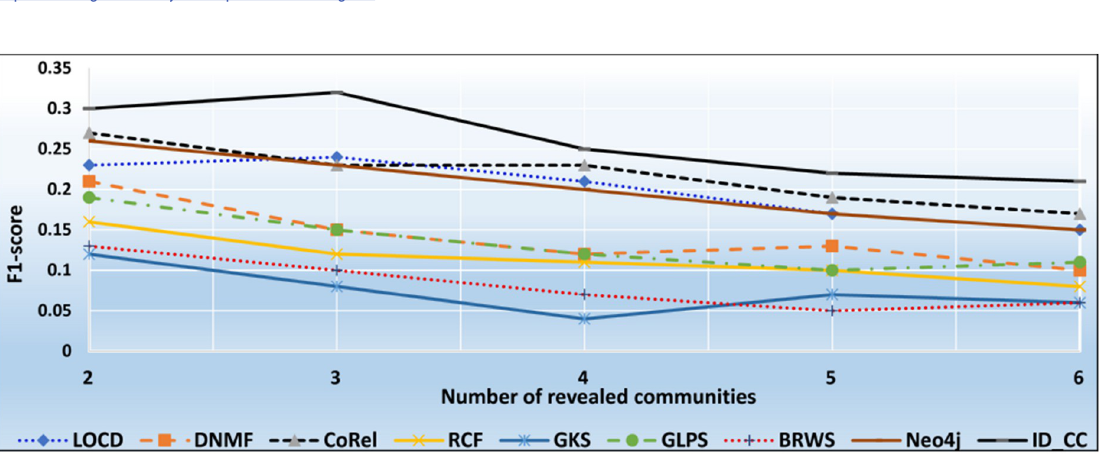
Fig 23. The accuracy of each method in terms of F1-score for detecting the DBLP cross-communities resulted from the overlapping of m number of communities ( m = 1, 2, ... , 6).